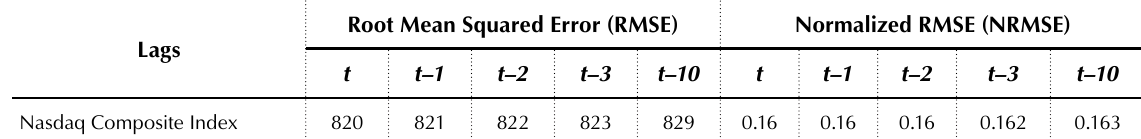
Table 3. Forecast errors Lags